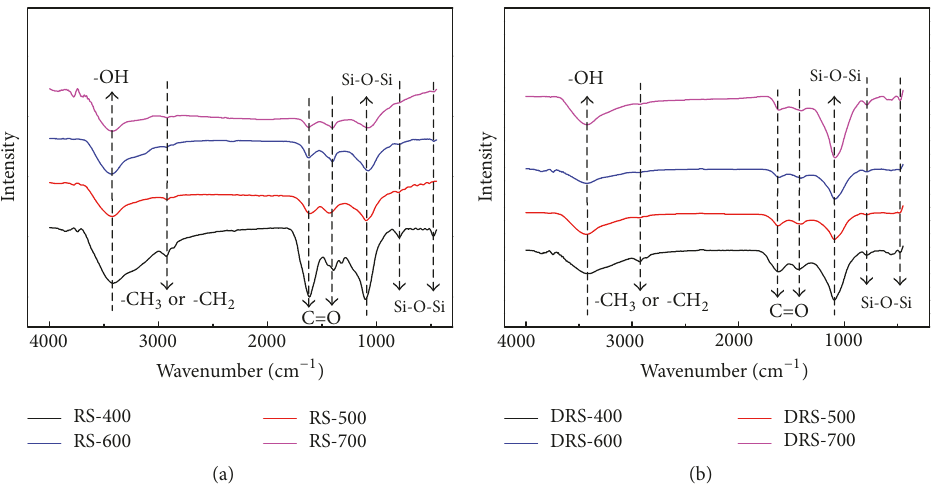
Figure 2: FT-IR spectra for RSBCs and DRSBCs. (a) RSBC; (b)